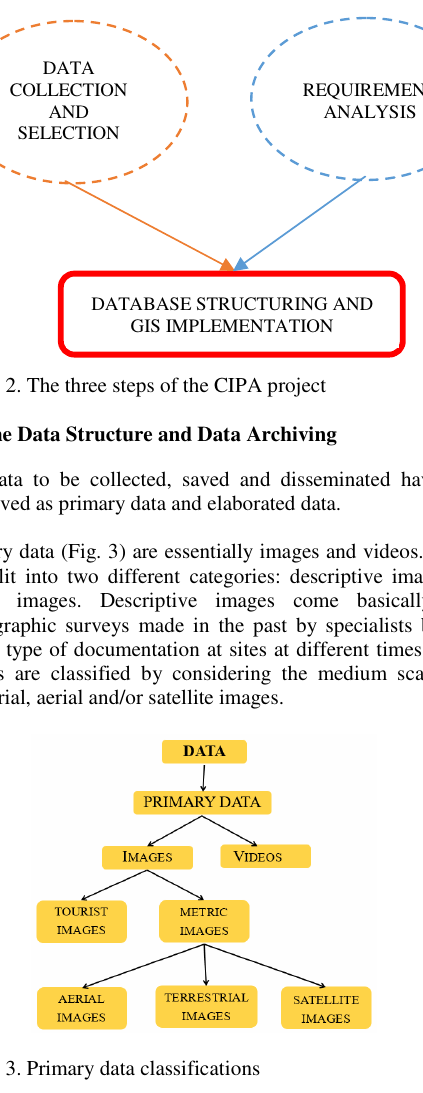
Figure 5. The CIPA website